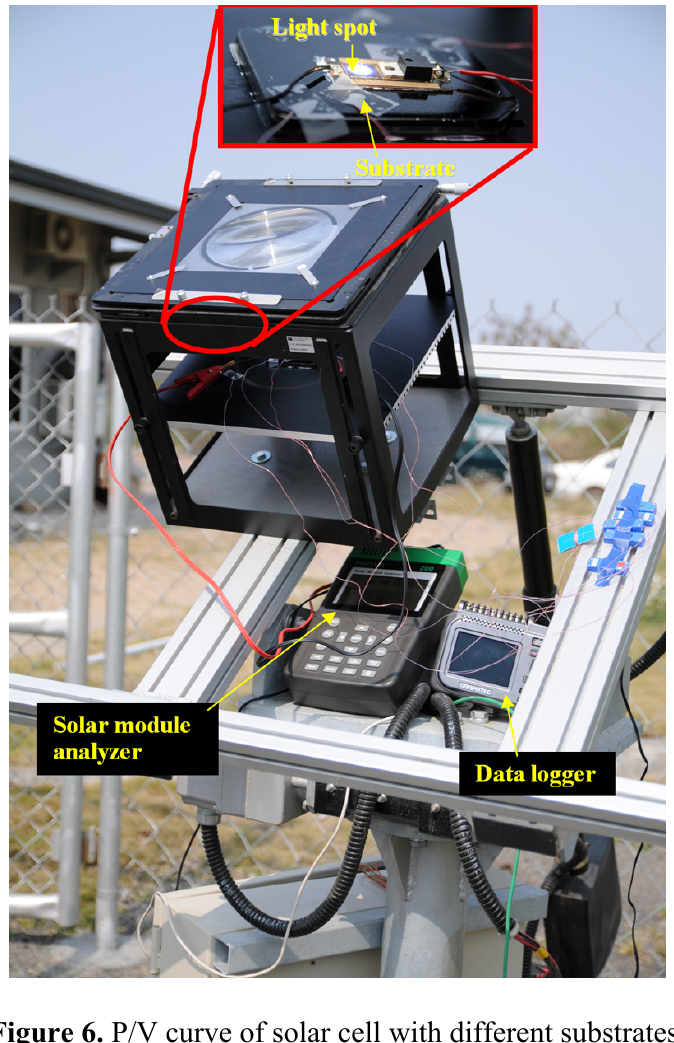
Figure 5. Constructed sun tracker.